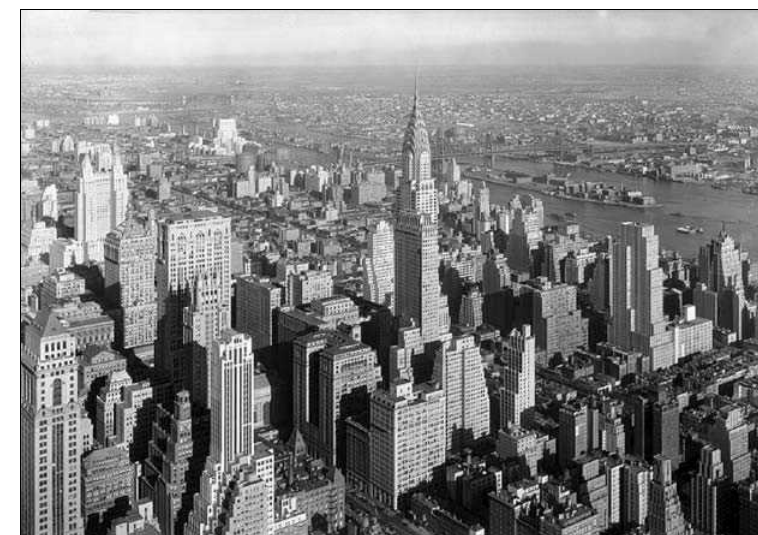
2 pav. Manheteno centras (1932 m.), atspindintis zonavimo taisyklių įtaką Fig. 1. hugh Feriss sketch, 1929 Fig. 2. Manhattan center of 1932 reflects Zoning Law influence on high-rise building architecture and urban